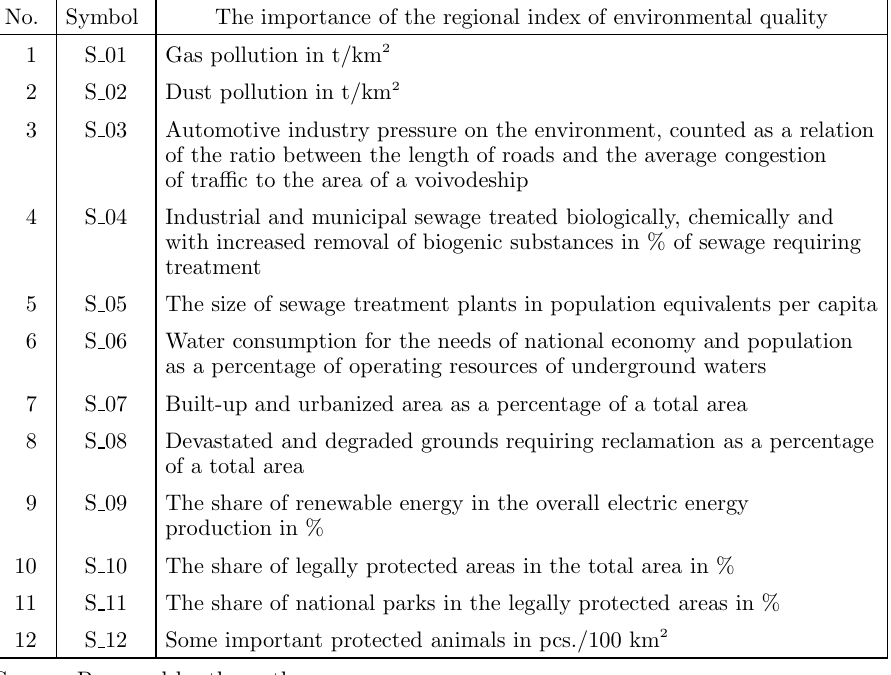
Basic parameters of the statistical analysis of observable variables in environmental and spatial dimension in 2010 and 2005